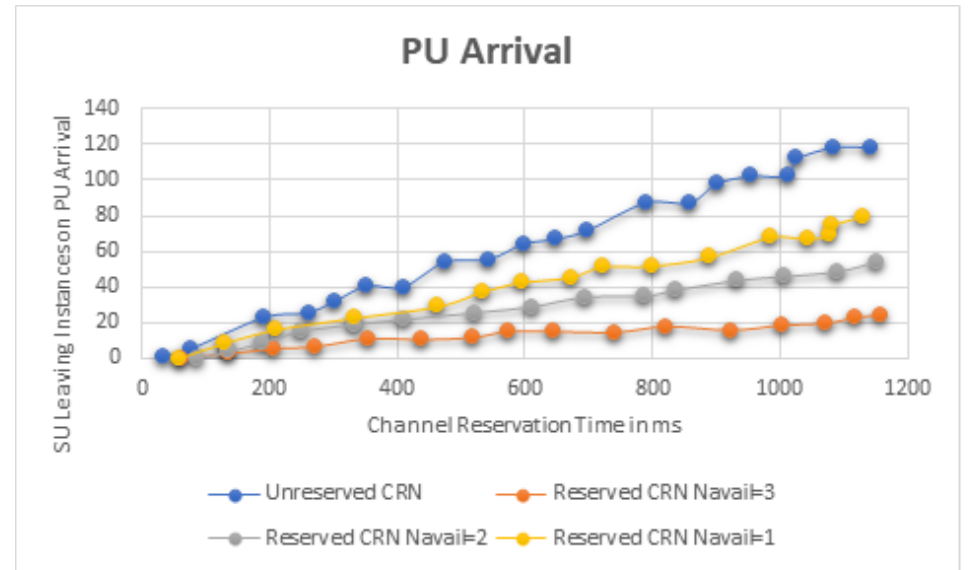
Figure 7. PU Channel Switching